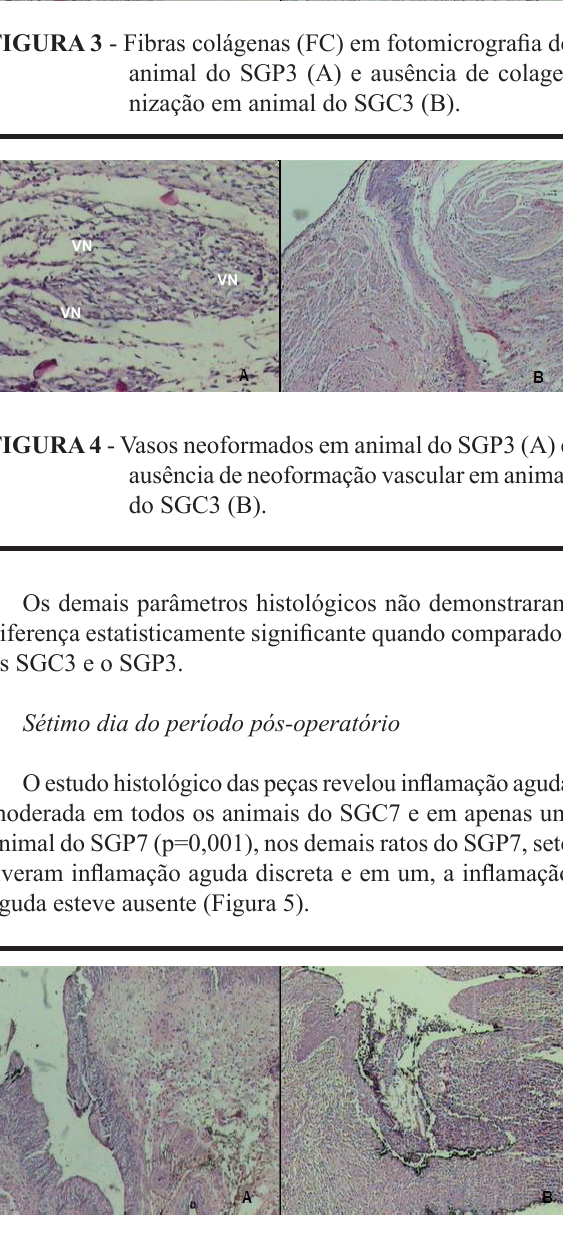
FIGURA 5 - Inflamação aguda moderada em animal do SGP7 (A) e inflamação aguda acentuada em animal do SGC7 (B).